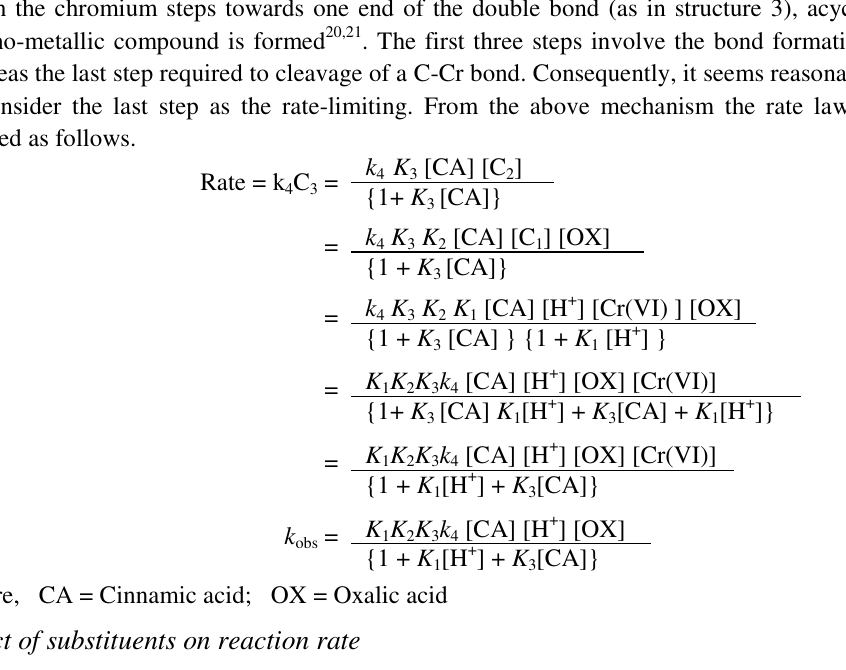
Table 5 thermodymamic parameters for the oxidation of substituted cinnamic acids by PBC in the presence of oxalic acid calculated from plots of ln ( k (r =